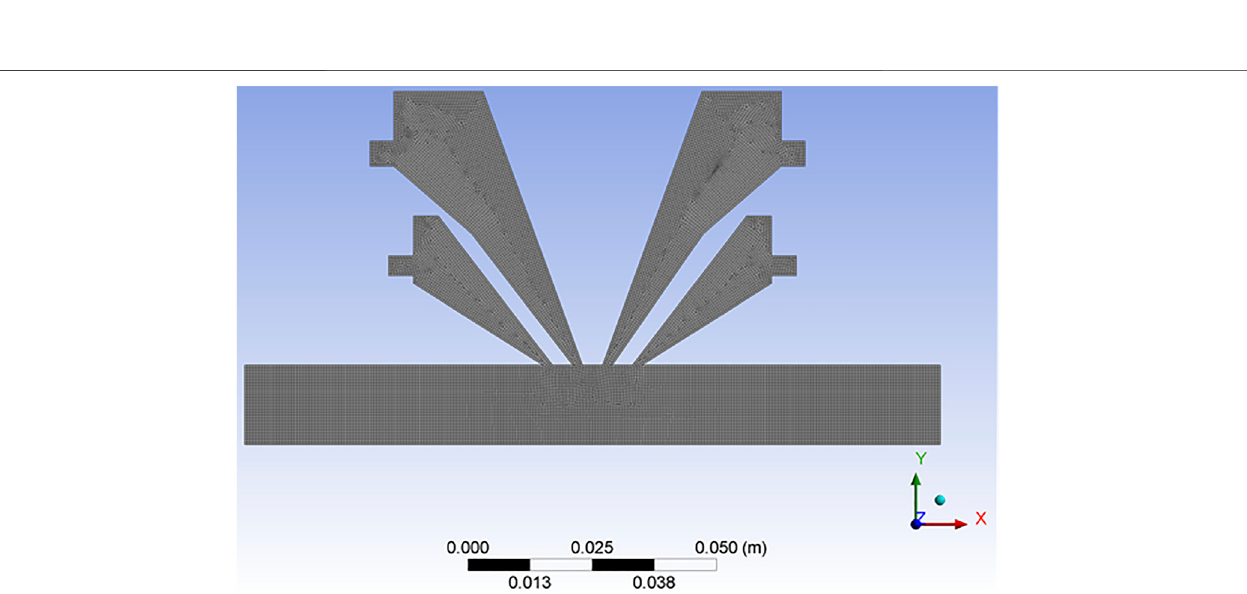
FIGURE 5 | Boundary condition representation.